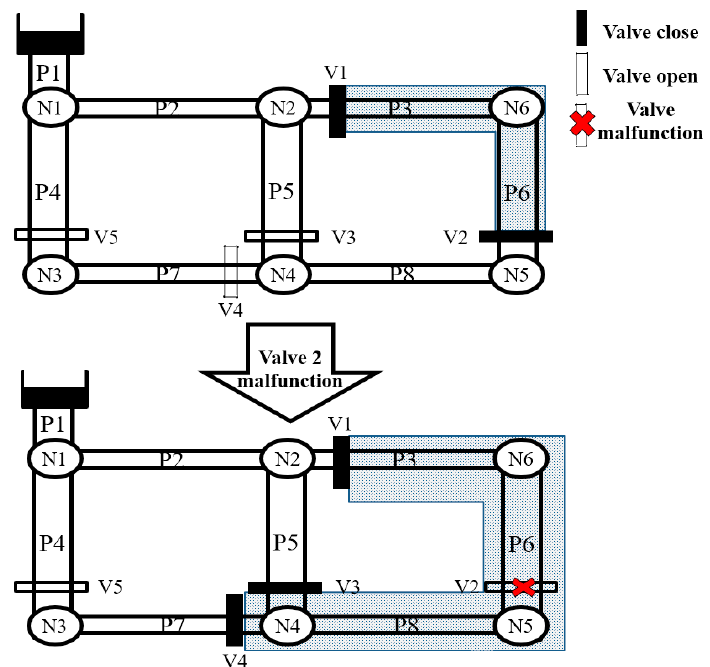
Figure 3. Concept of valve failure